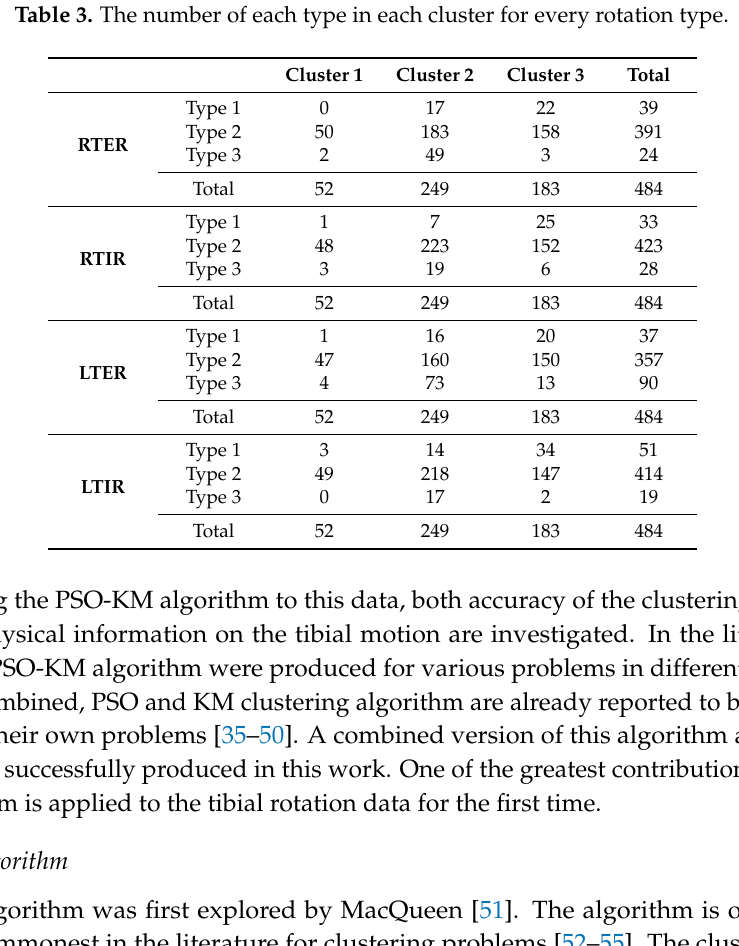
Table 3. The number of each type in each cluster for every rotation type.